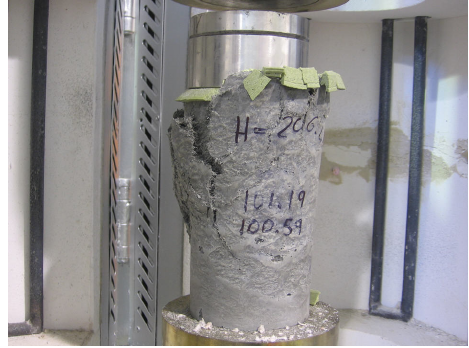
Figure 3. Destructive compression applied on an ECC specimen on Day ‐ 3.